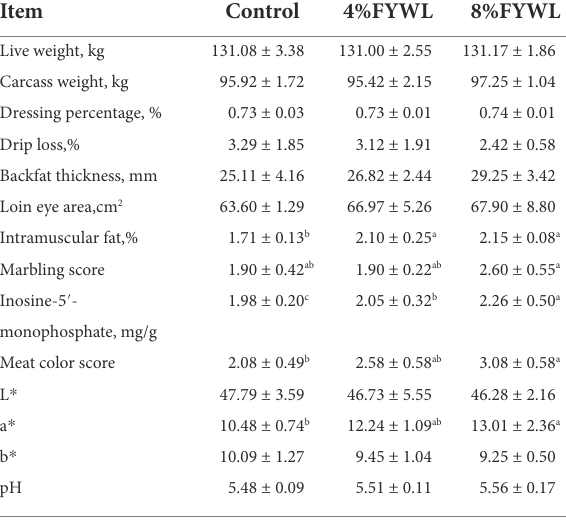
TABLE 8 Effect of FYWL on serum immunity.